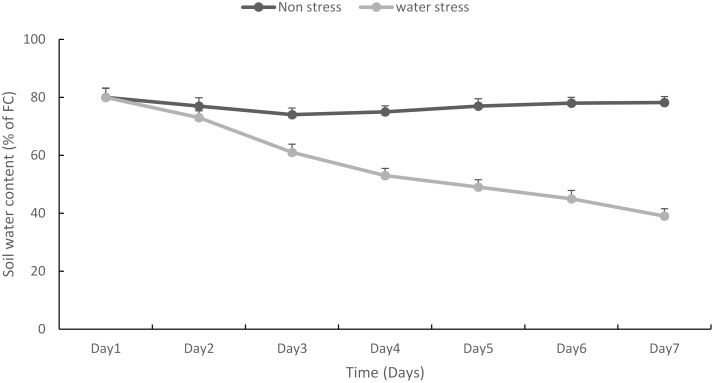
Change in the soil water content (SWC) [% of field capacity (FC)] with time (days) for non-stressed (upper line) and water stressed (lower line) treatment after watering was withheld for 7 days. Values are means; error bars are standard errors of the means.